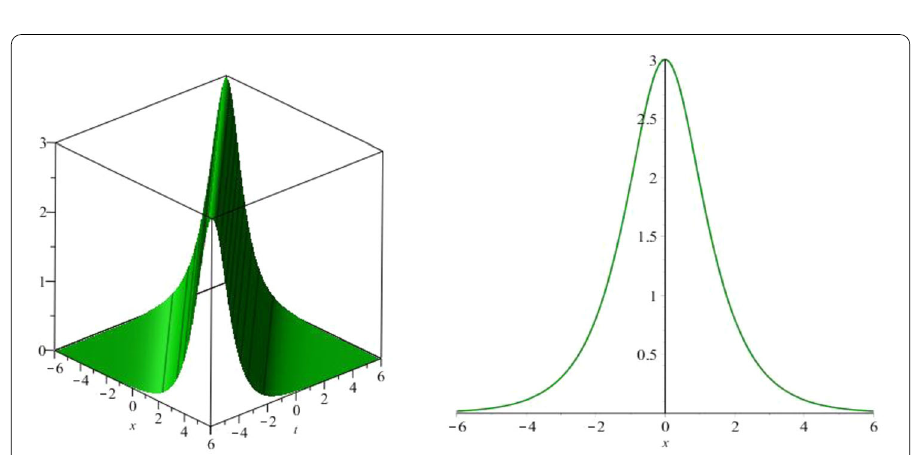
Figure 4 3D plot for φ 16 at y = 1 with σ = μ = k = δ = 1 and 2D at t = 0